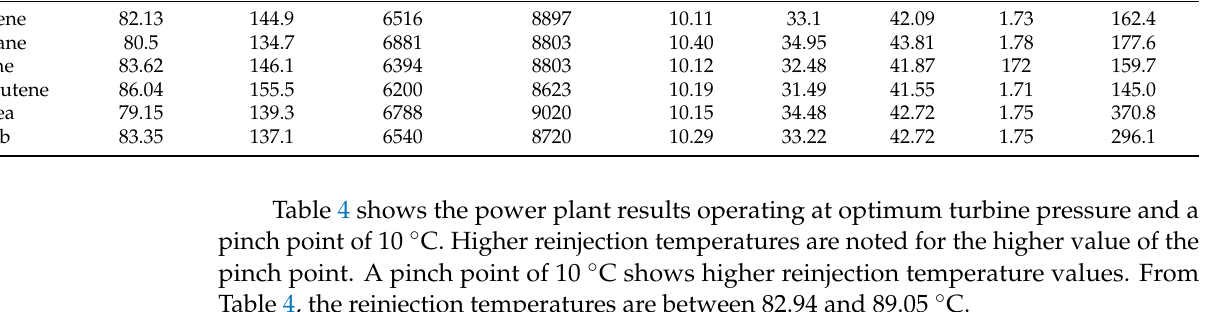
Table 3. Optimized model for different working fluids for 8 ◦ C pinch point for the simple ORC model. Fluid